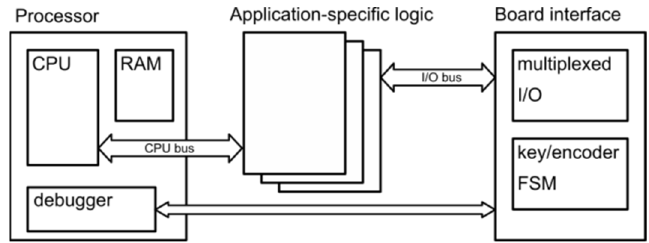
Figure 6. Block diagram of the final project digital system.